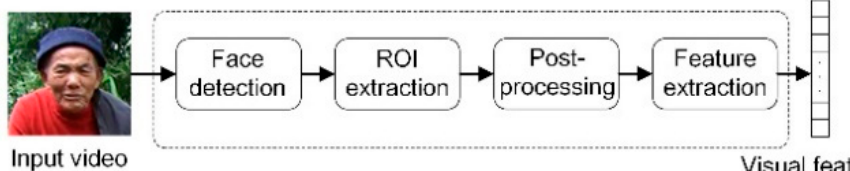
Figure 2. Extraction of visual